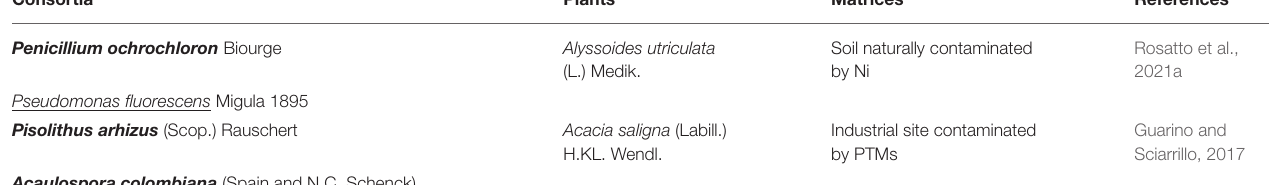
TABLE 1 | List of the main fungal-bacterial consortia employed for the attenuation of PTM stress and the improvement of phytoremediation efficiency in plants.